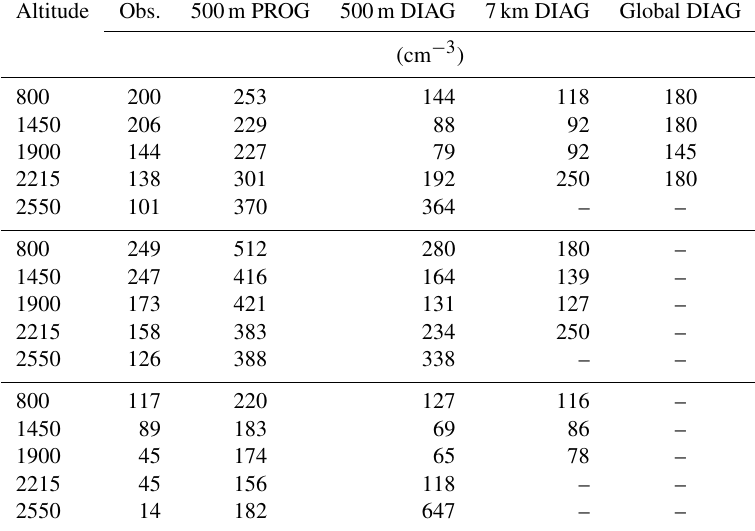
Figure 7. Updraught speed in clouds in 32Hz CLARIFY observations and in the model (before changes to the activation scheme) at altitudes of 800, 1450, 1900, 2215 and 2550m from left to right. Model data are from instantaneous simulation output of the 200m, 500m and the 7km resolution simulations at 12:00UTC on 19 August 2017. Only the area of the 7km resolution simulation that overlaps with the 500m resolution simulation is included. Data are selected as being in-cloud data if the liquid water content exceeds 0.01gkg − 1 in both the model and in the observations. The histograms of simulated vertical velocity are scaled so their maxima match the maximum of the histogram of the observed vertical velocity. Table 3. Cloud droplet number concentrations in all clouds and in two bins of liquid water content. The 500m resolution, 7km resolution and global models are shown, with the ARG (DIAG) and ARG (PROG) activation schemes where they are run. In both model and observations, the threshold liquid water content to define a cloud is 0.01gkg − 1 . All data are shown above the first horizontal line; the model grid cells and observations with in-cloud liquid water content above 0.15gkg − 1 are shown above the second horizontal line, and those with liquid water content below 0.15gkg − 1 are shown below. The global model, labelled “Global DIAG”, is not separated by liquid water content as the number of grid boxes in the domain is too small. Altitude Obs. 500m PROG 500m DIAG 7km